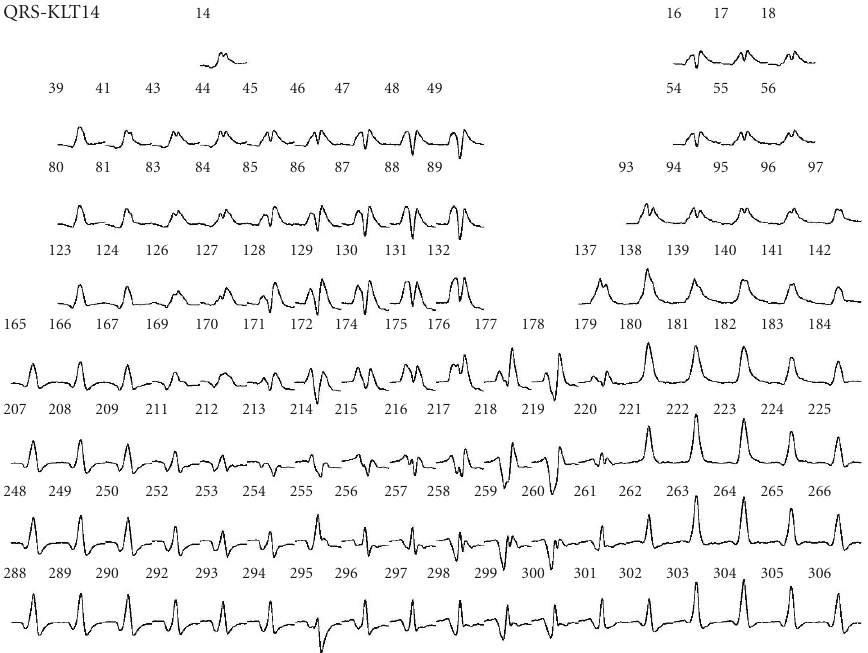
Figure 14: Basis function B n , l derived from the BSPM data displayed in Figure 13, using lead piling ( B n , l is obtained by depiling the eigen- vector of order